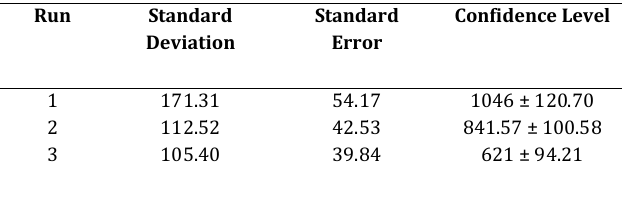
Table 3(b): Statistical analysis of the optimum concentration pineapple peel substrate